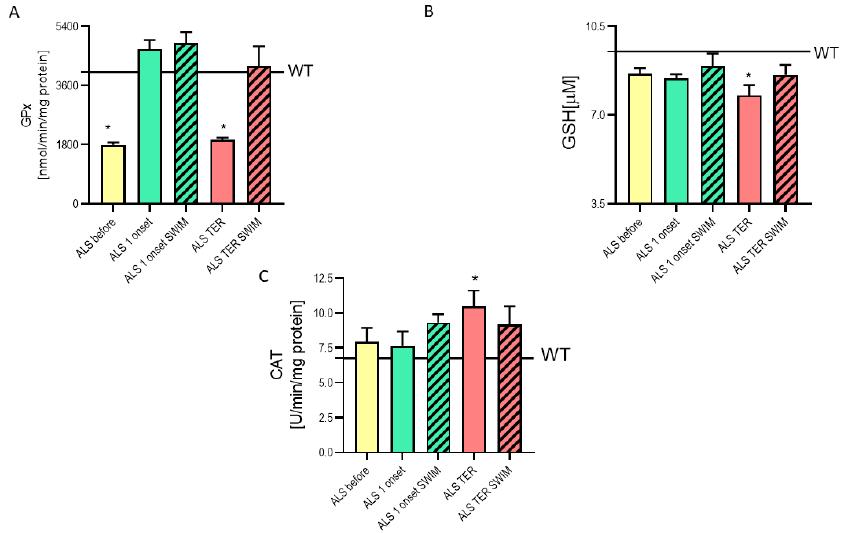
Figure 4. The antioxidative enzyme activities and reduced glutathione (GSH) concentration in the spinal cord: ( A ) Glutathione peroxidase activity, WT = 4001.0 ± 435.4 nmol/min/mg protein, * p < 0.05 versus WT and the rest of the ALS groups (WT n = 6, ALS before n = 8, ALS 1 onset n = 7, ALS 1 onset SWIM n = 5, ALS TER n = 9, ALS TER SWIM n = 10). ( B ) GSH concentration, WT = 9.35 ± 0.47